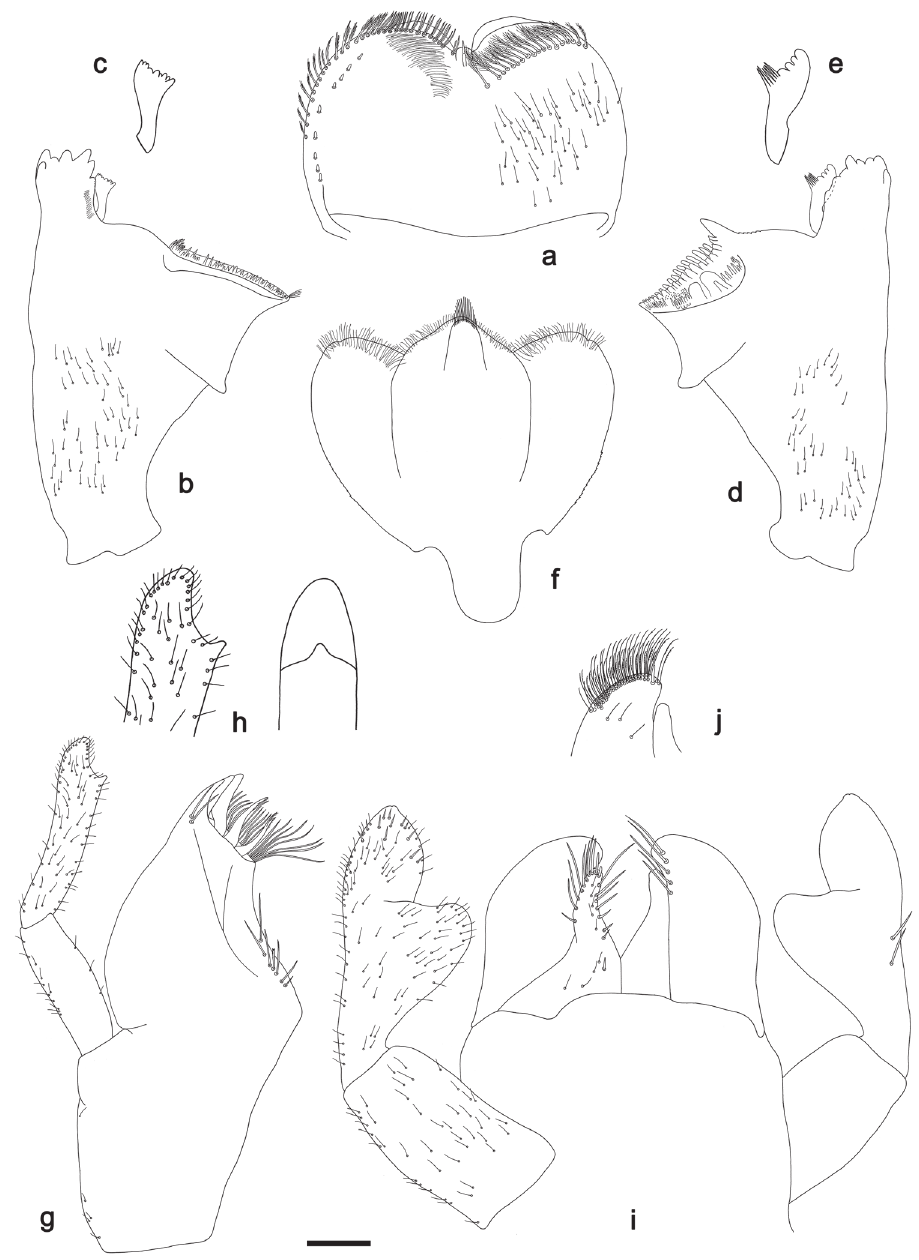
Figure 5. Labiobaetis excavatus sp. nov., nymph morphology: a labrum b right mandible c right pros- theca d left mandible e left prostheca f hypopharynx and superlinguae g maxilla h apex of maxillary palp (left: dorsal view, right: inner lateral view) i labium j apex of paraglossa. Scale bar: 0.1